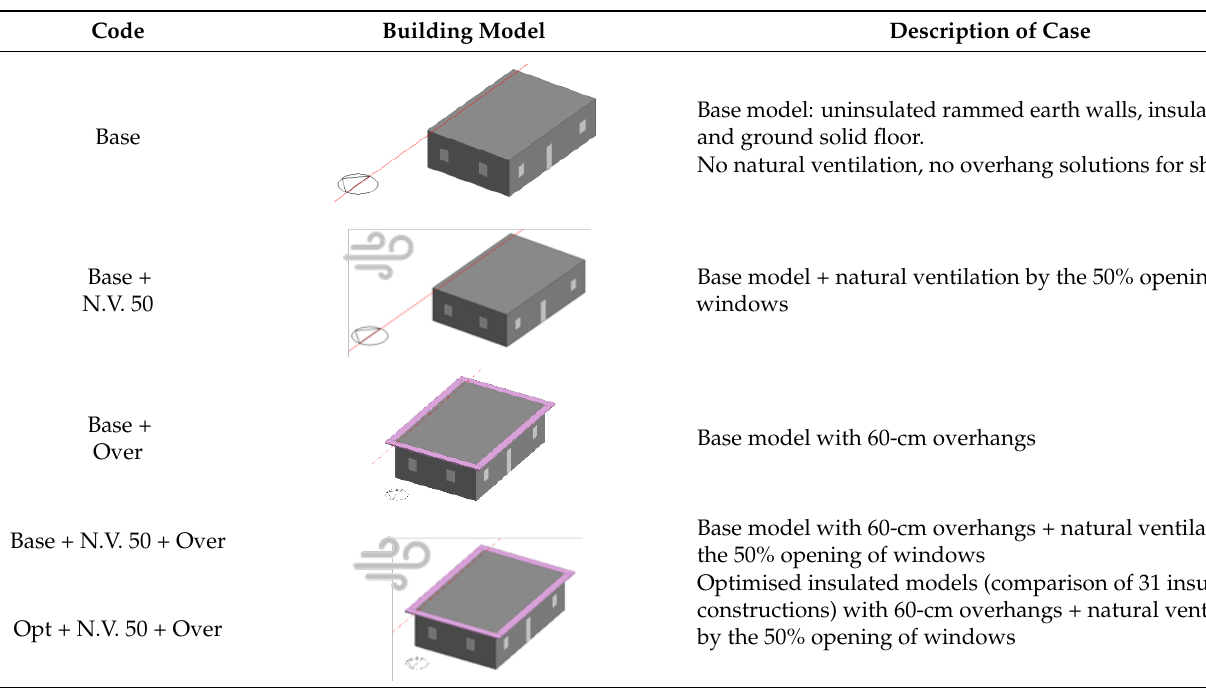
Table 4. Codification for the simulated